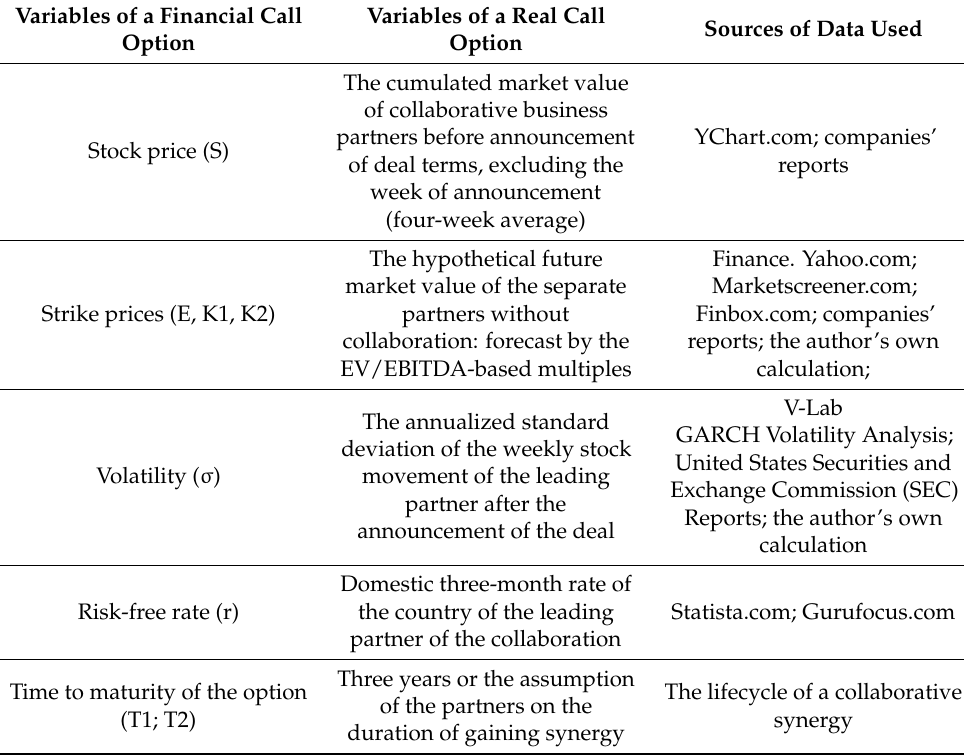
Table 2. The correspondence between real and financial call